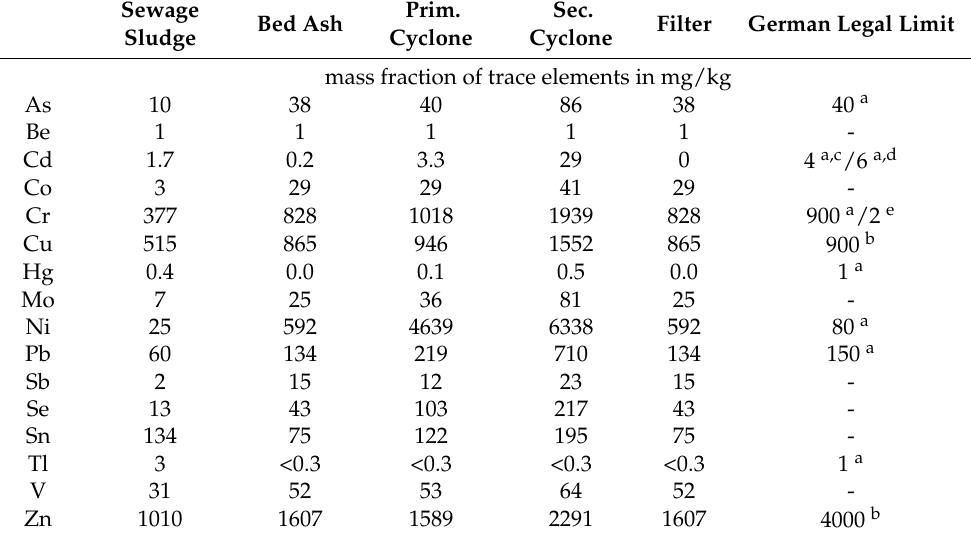
Table 9. Heavy metal concentration in sewage sludge and ash fractions, for comparison: